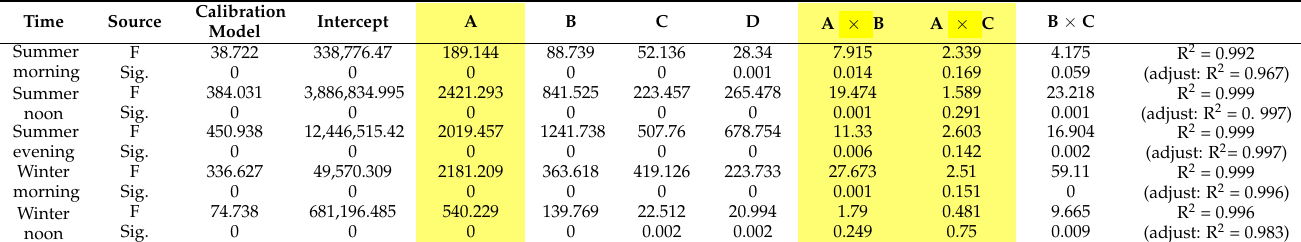
Table 9. Analysis of variance results of various factors in summer and